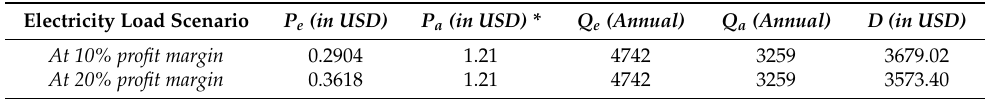
Table 8. Economic benefit to consumers (Gilutongan).